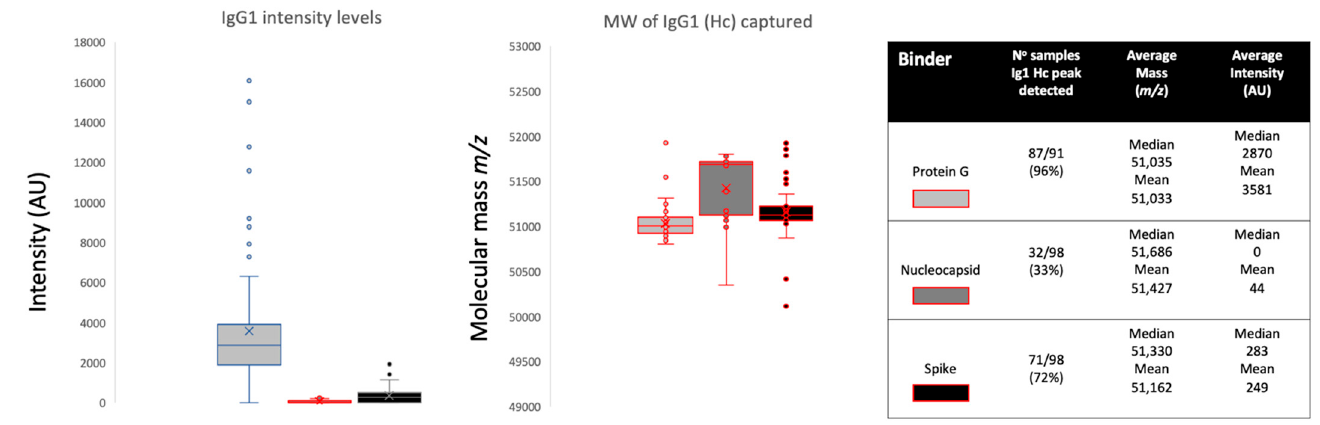
Figure 2. Relative intensities and variance in peak apex molecular mass of IgG1 heavy chains (IgG1 Hc) recovered from the same samples by protein G, nucleocapsid and stabilized spike protein. The non-parametric Kruskal − Wallis statistical test was carried out to test differences between study cohorts. The p values (alpha: 0.05) were as follows: intensity p < 0.0001 and molecular mass p < 0.0001.